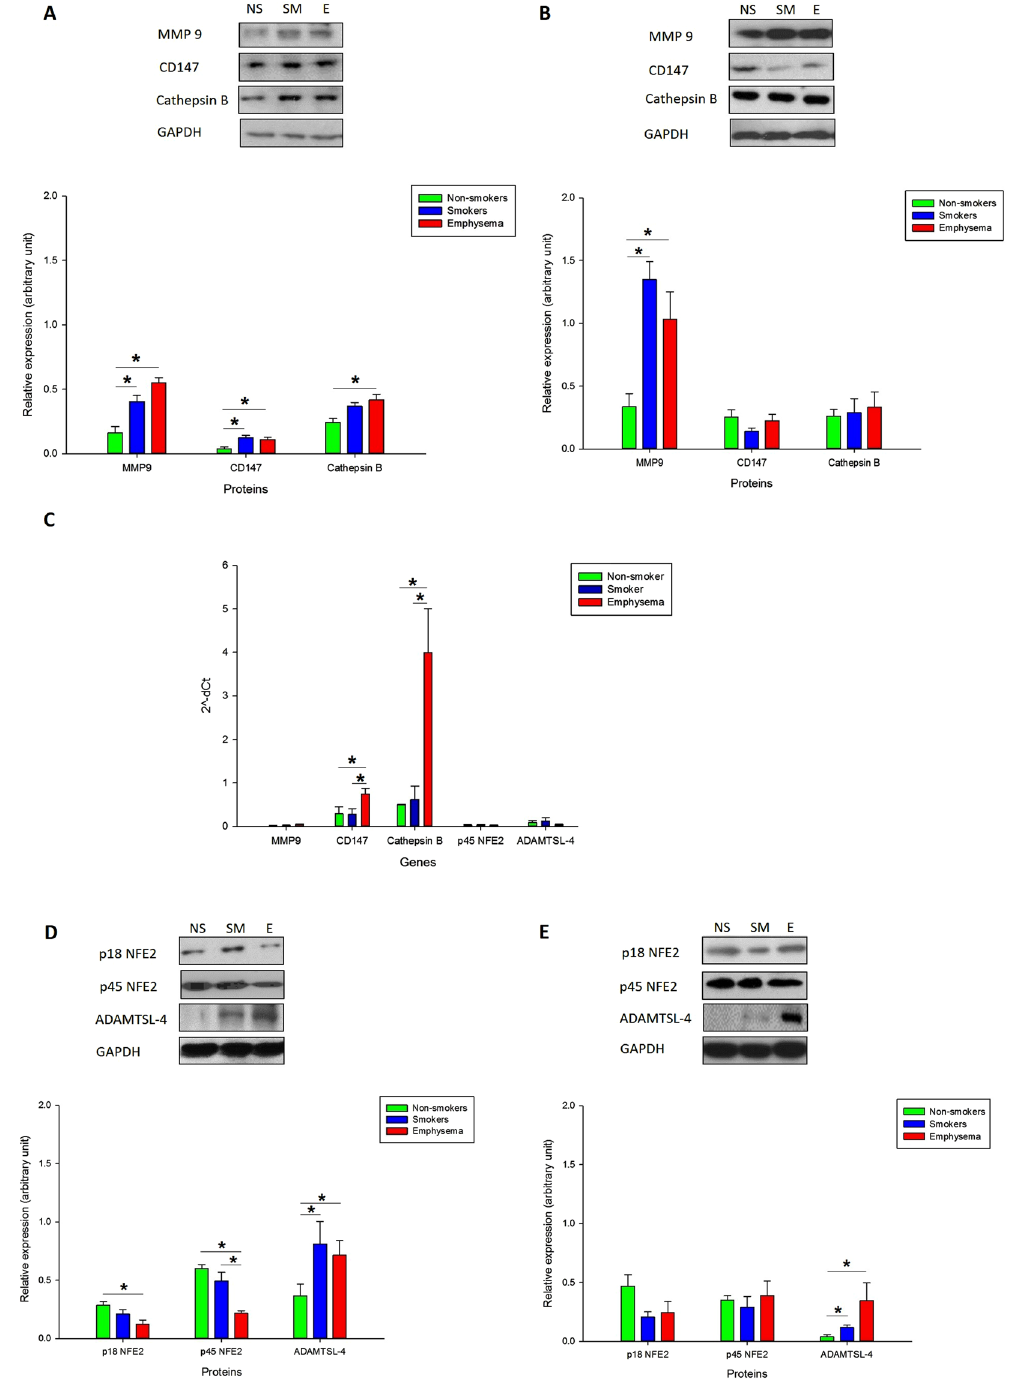
Figure 1. MMP9, CD147, cathepsin B, p18 NFE2, p45 NFE2 and ADAMTSL-4 expression in ATII cells and lung tissue obtained from non-smokers (NS), smokers (SM) and patients with emphysema (E). MMP9, CD147 and cathepsin B expression in freshly isolated ATII cells ( A ) and lung tissue ( B ) as detected by Western blotting analysis. ( C ) MMP9, CD147, cathepsin B, p45 NFE2 and ADAMTSL-4 mRNA levels in lung tissue by RT-PCR. ( D,E ) p18 NFE2, p45 NFE2 and ADAMTSL-4 expression in freshly isolated ATII cells ( D ) and lung tissue ( E ). Protein levels were analyzed by Western blotting. Densitometric analysis is also shown. * Statistically significant difference ( p < 0.05) is shown for comparison between non-smokers and smokers, between smokers and emphysema patients and between non-smokers and emphysema patients. Data are shown as the mean ( ±